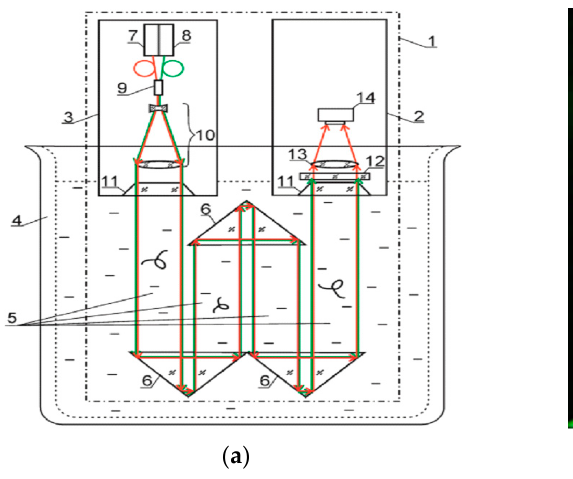
Figure 2. DHC-based laboratory unit and ( a ) photo of light columns with hydrobionts ( b ): ( a ): 1—DHC, 2—DHC recording unit, 3—DHC lighting module, 4—laboratory water tank, 5—test (working) volume formed by recording (red) and attracting (green) light beams, 6—mirror-prism system for working volume forming, 7—semiconductor laser diode ( λ = 650 nm), 8—semiconductor laser diode ( λ = 532 nm), 9—fiber-optic multiplexer (mixer), 10—beam expander, 11—windows, 12—selective filter, 13—receiving lens, 14—CMOS